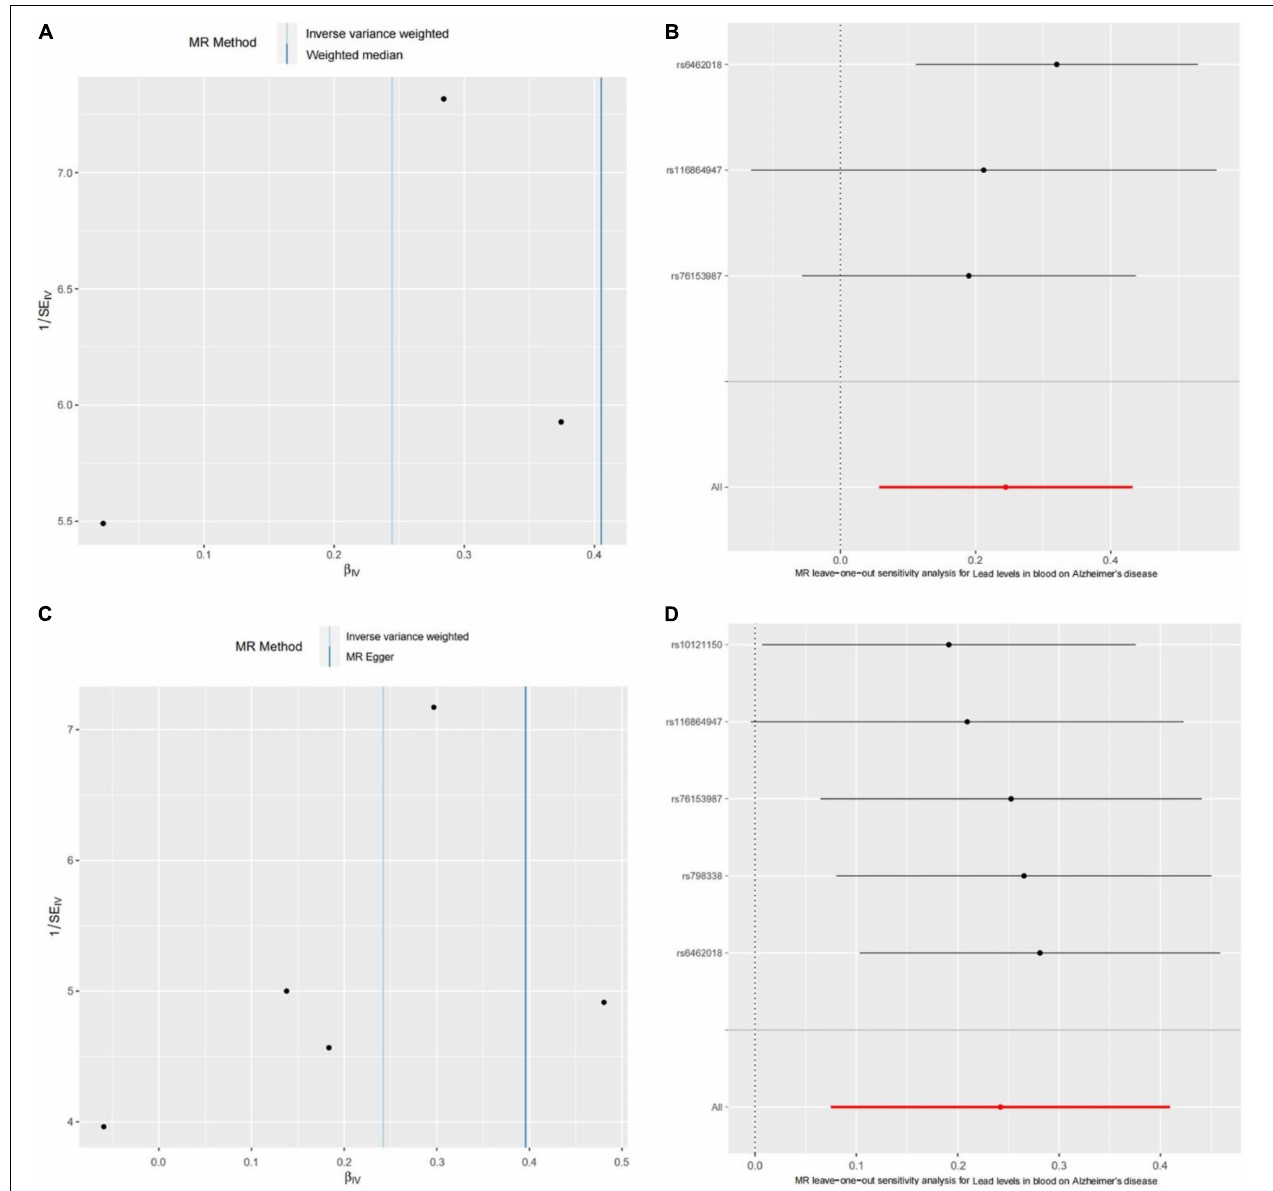
FIGURE 2 | The heterogeneity test and sensitivity analysis of the Mendelian randomization analysis. (A) Funnel plot to assess heterogeneity. Asymmetry and large spread suggest a high heterogeneity. (B) The forest plot of leave-one-out sensitivity analysis shows if an association is being disproportionately influenced by a single SNP. Each black point represents the Mendelian randomization analysis excluding that particular SNP. Panels (C,D) show the results of the heterogeneity test and leave-one-out sensitivity analysis for the EFO_0000249 dataset,